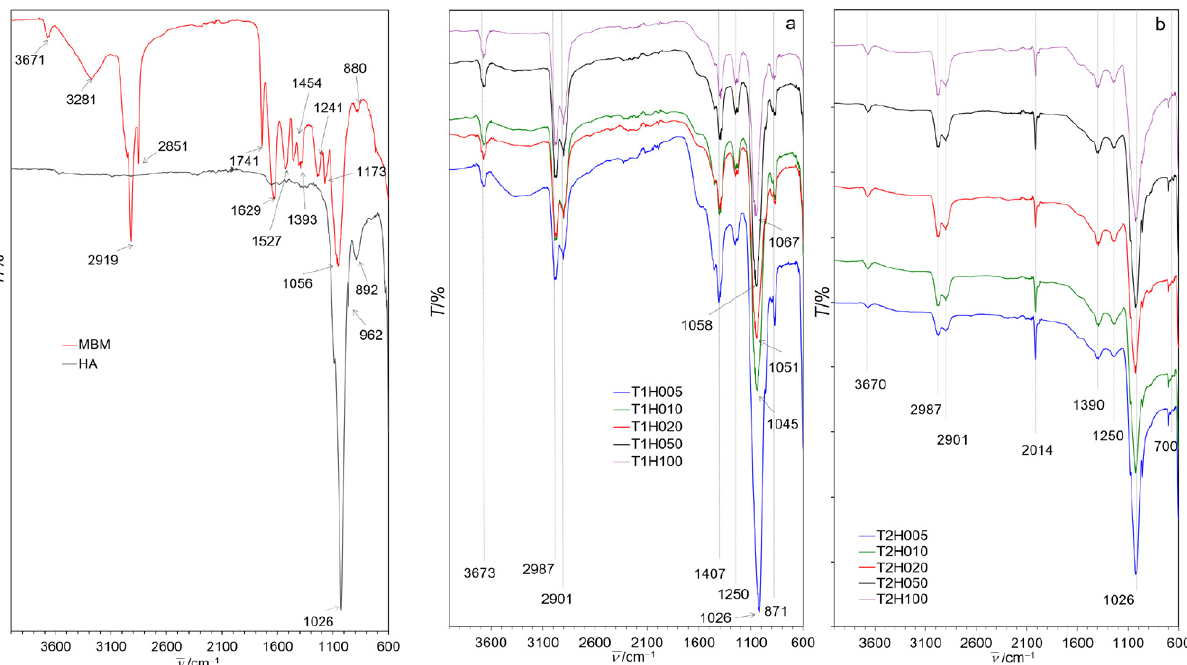
Figure 5. FTIR spectra of untreated MBM sam- ple and commercially available hydroxyapatite.